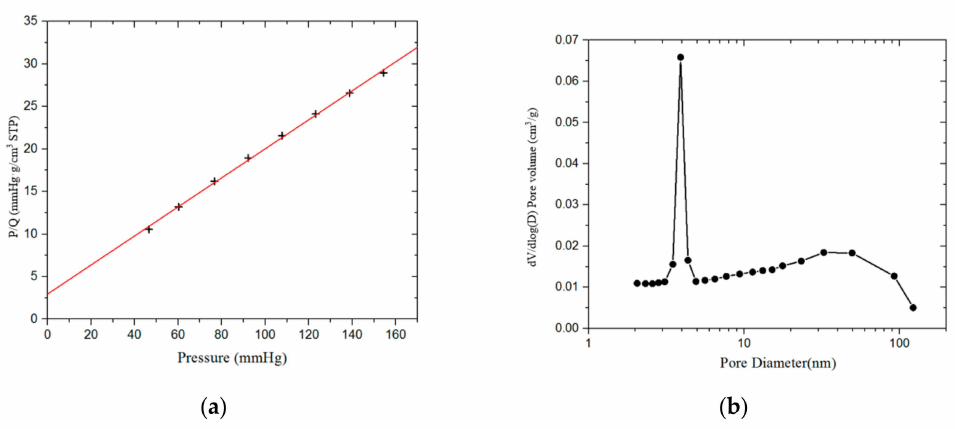
Figure A3. Nitrogen adsorption of sample 1 measured by an ASAP 2420 instrument (Micromeritics Instrument Corp., Norcross, GA, USA). ( a ) Langmuir surface area plot; ( b ) BJH desorption dV / dlog(D) pore volume.